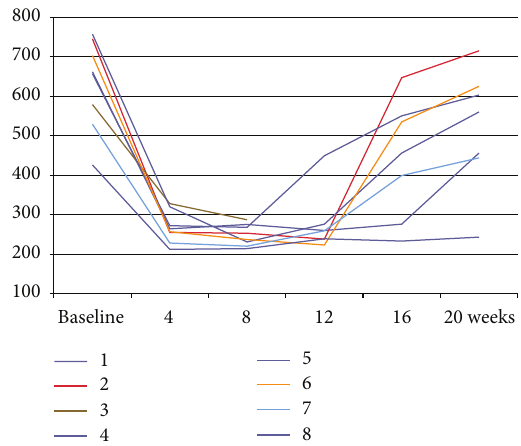
Figure 1: Retinal thickness dependence of the duration of Ozurdex 0.7 mg in the vitreous. Coloured lines refer to the serial numbers of injections from Table